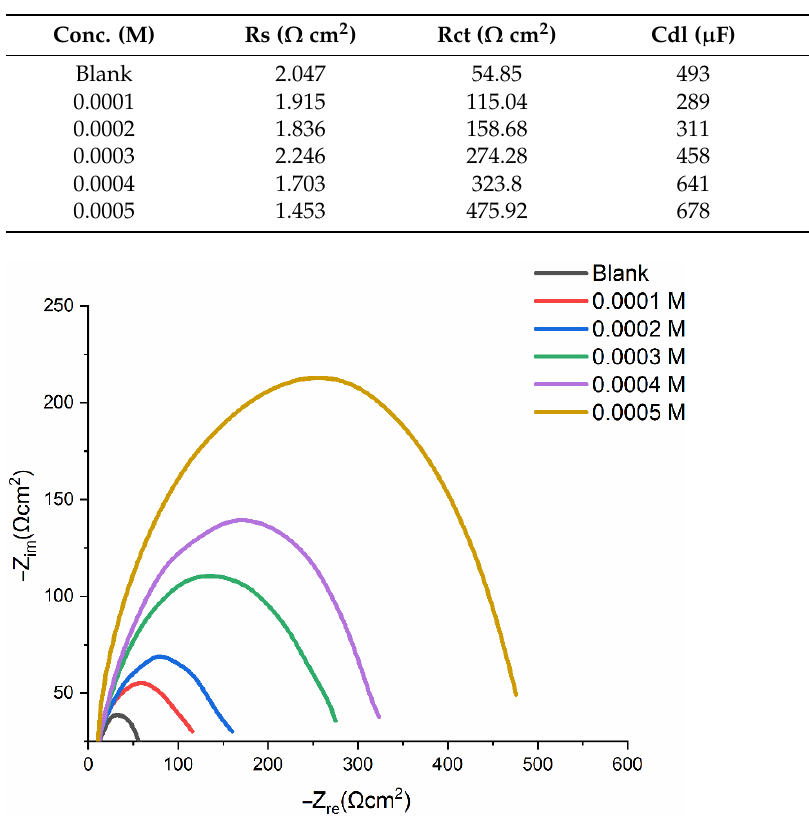
Table 4. EIS parameters for mild-steel coupon without and with the addition of various concentrations of PMBMH in 1 M corrosive solution.